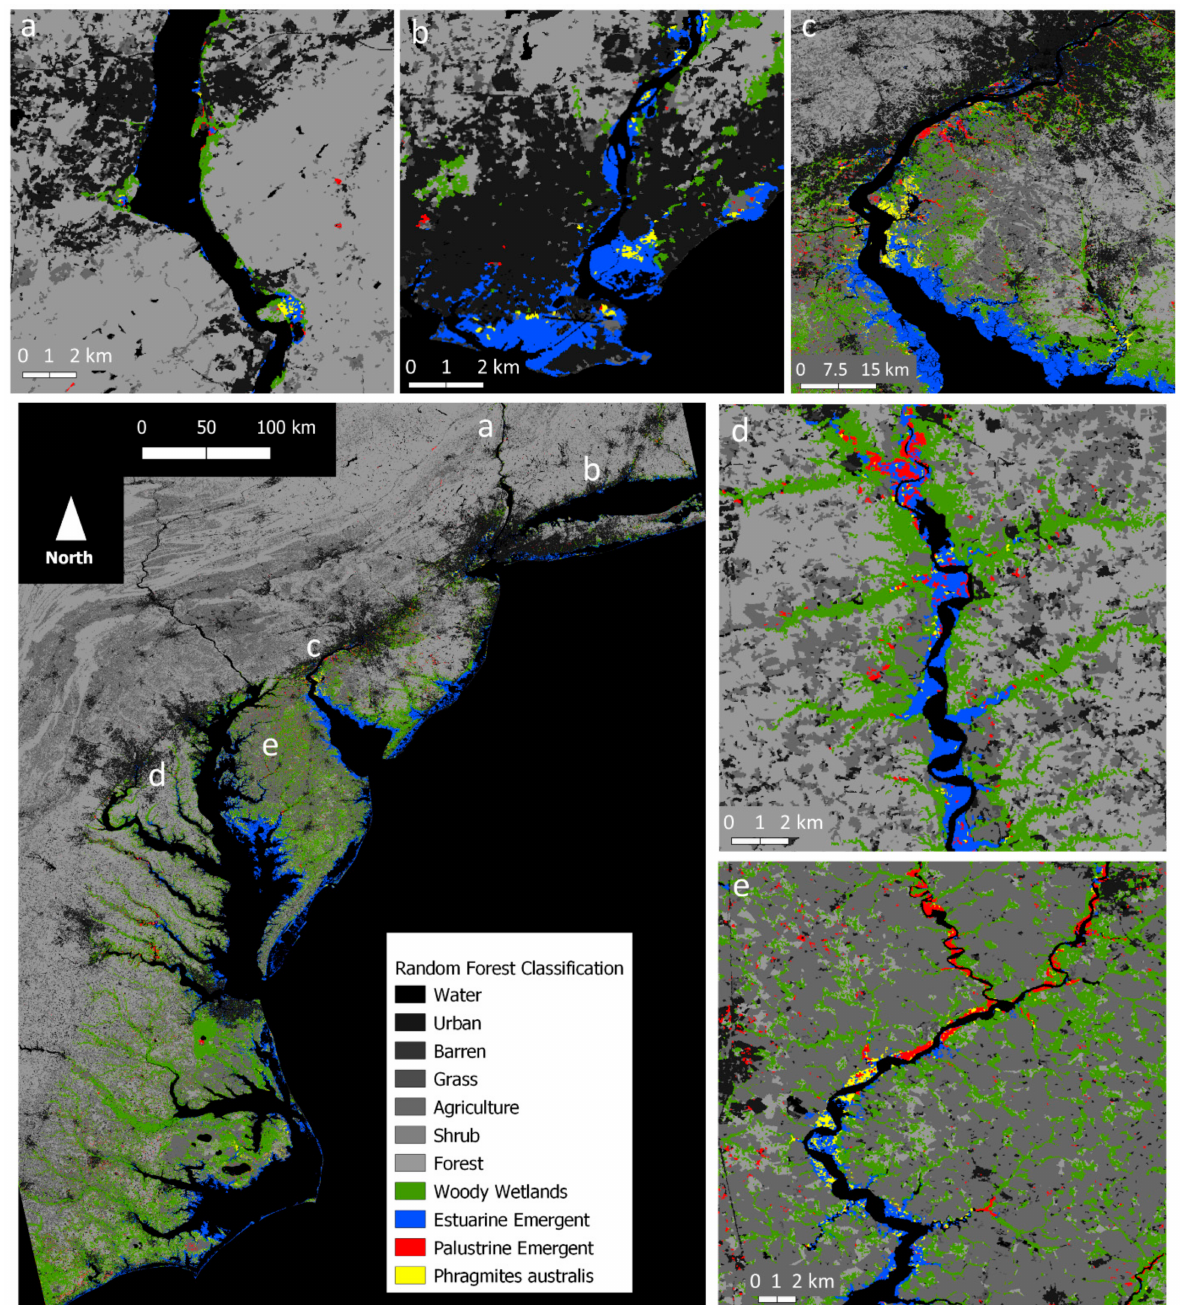
Figure 11. Mid-Atlantic level-1 classification using random forest. Panels a – e depict finer scale maps of the Hudson River wetlands ( a ), Housatonic River wetlands ( b ), Delaware River wetlands ( c ), Patuxent River wetlands ( d ), and Choptank River wetlands ( e ). The three separate emergent wetland classes are mapped with greater than 81% accuracy in all cases (see Table 2 confusion matrix). A clumped emergent wetland class (estuarine emergent, palustrine emergent, and P. australis ) was mapped with a user’s accuracy of 89.69% and producer’s accuracy of